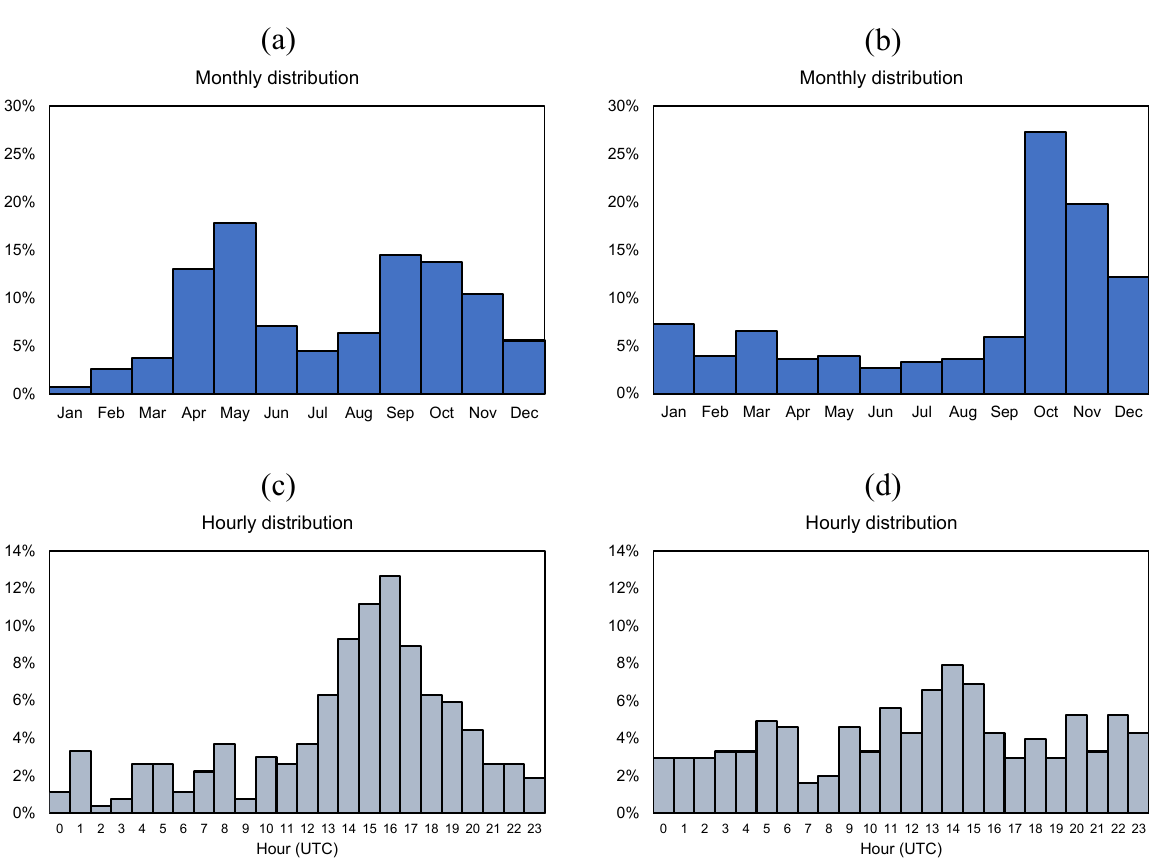
Figure 7. Histogram of the monthly distribution of the occurrences (in %) of SHHP multi-site events for ( a ) RegL and ( b ) RemL. ( c , d ) are the same as ( a , b ) but show the hourly distribution.